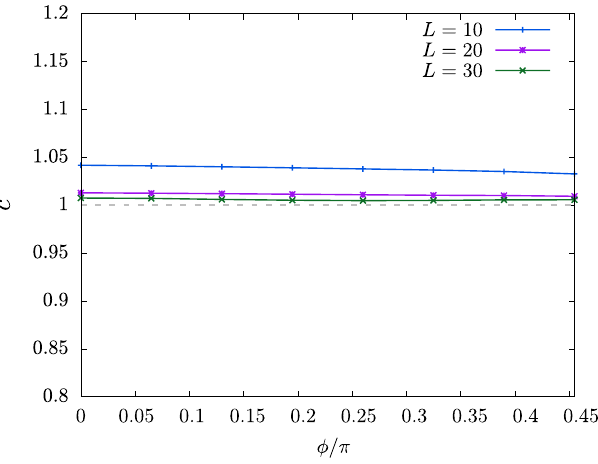
Figure 8. Central charge, calculated with periodic L = 10, 20, and 30 chains, as a function of φ